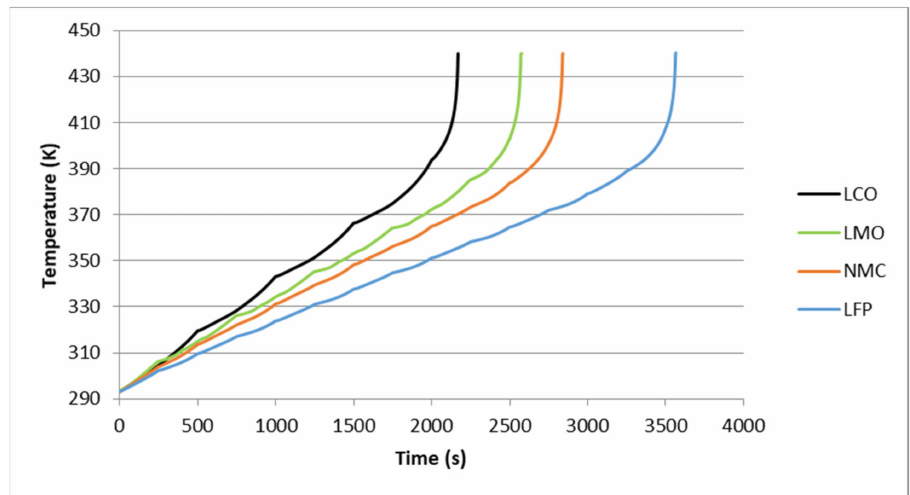
Figure 9. Temperature profiles as a function of time (h = 2 W/m 2